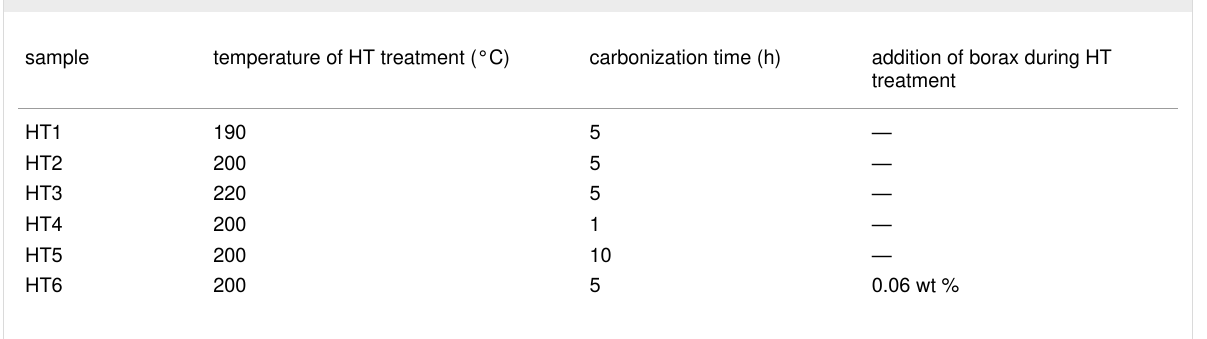
Table 2: Synthesis conditions for the six HT